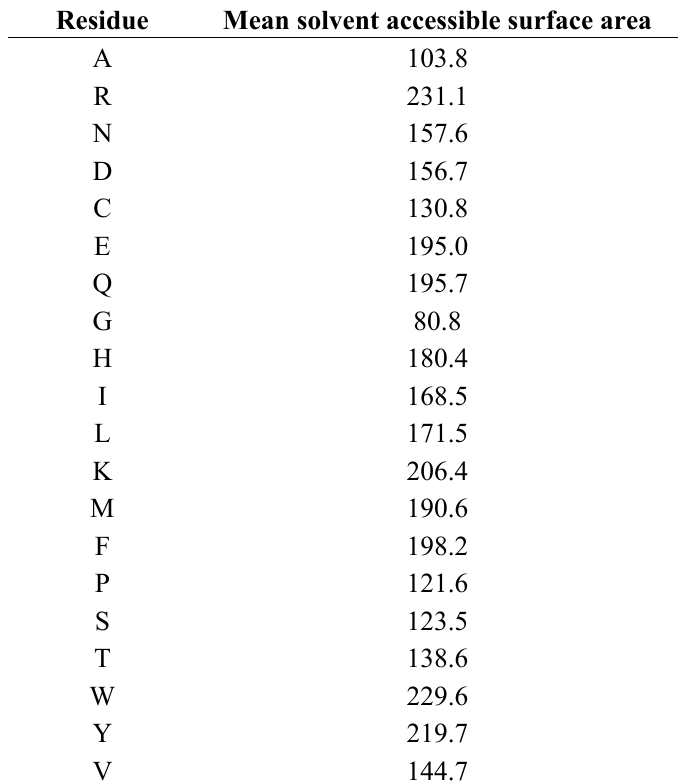
Table 1. Mean solvent accessible surface area per residue used for